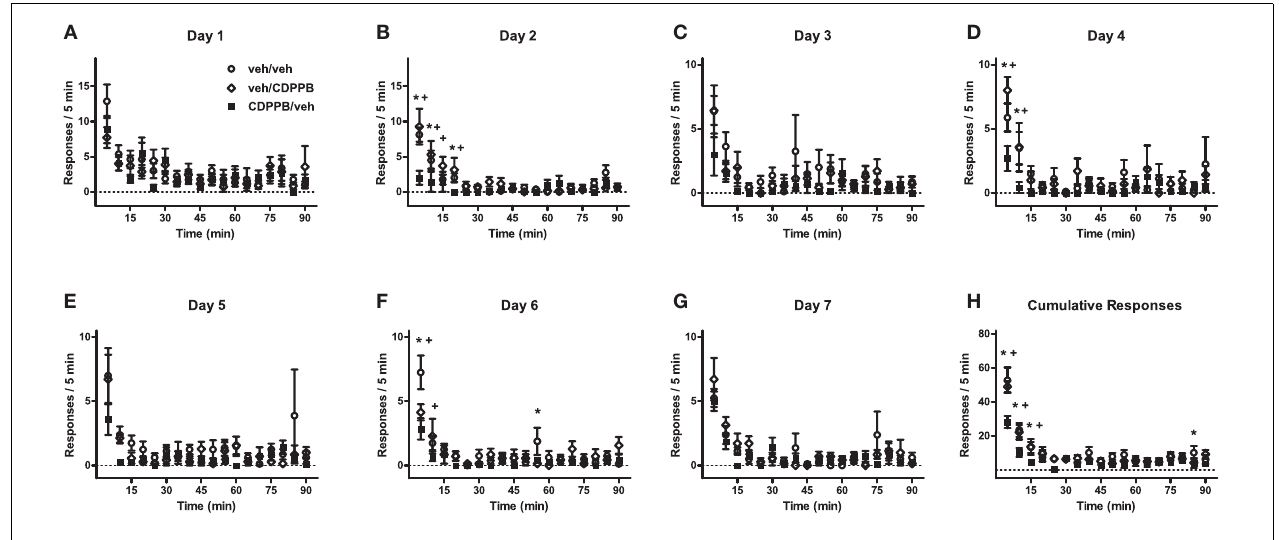
bins and analyzed with mixed factorial ANOVA. * p < 0.05 difference between veh/veh and CDPPB/veh groups ( post hoc Newman–Keuls tests). + p < 0.05 difference between veh/CDPPB and CDPPB/veh groups (Newman–Keuls tests).